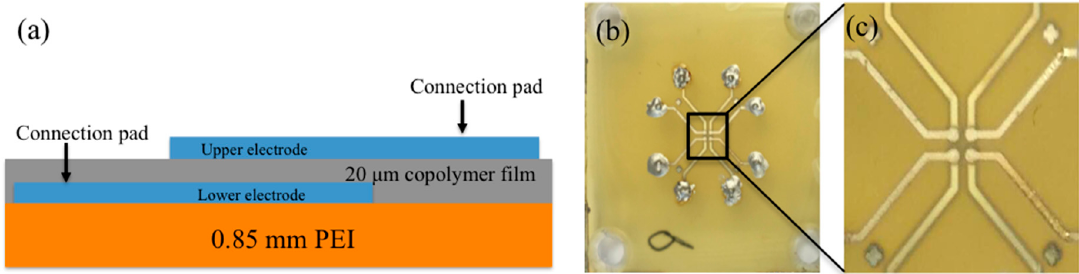
Figure 1. Schematic diagram of the adhesive free transducer ( a ), ( b ) the P(VDF-TrFE) unfocused transducer containing all four elements, ( c ) shows the magnified view of the figure ( b ).